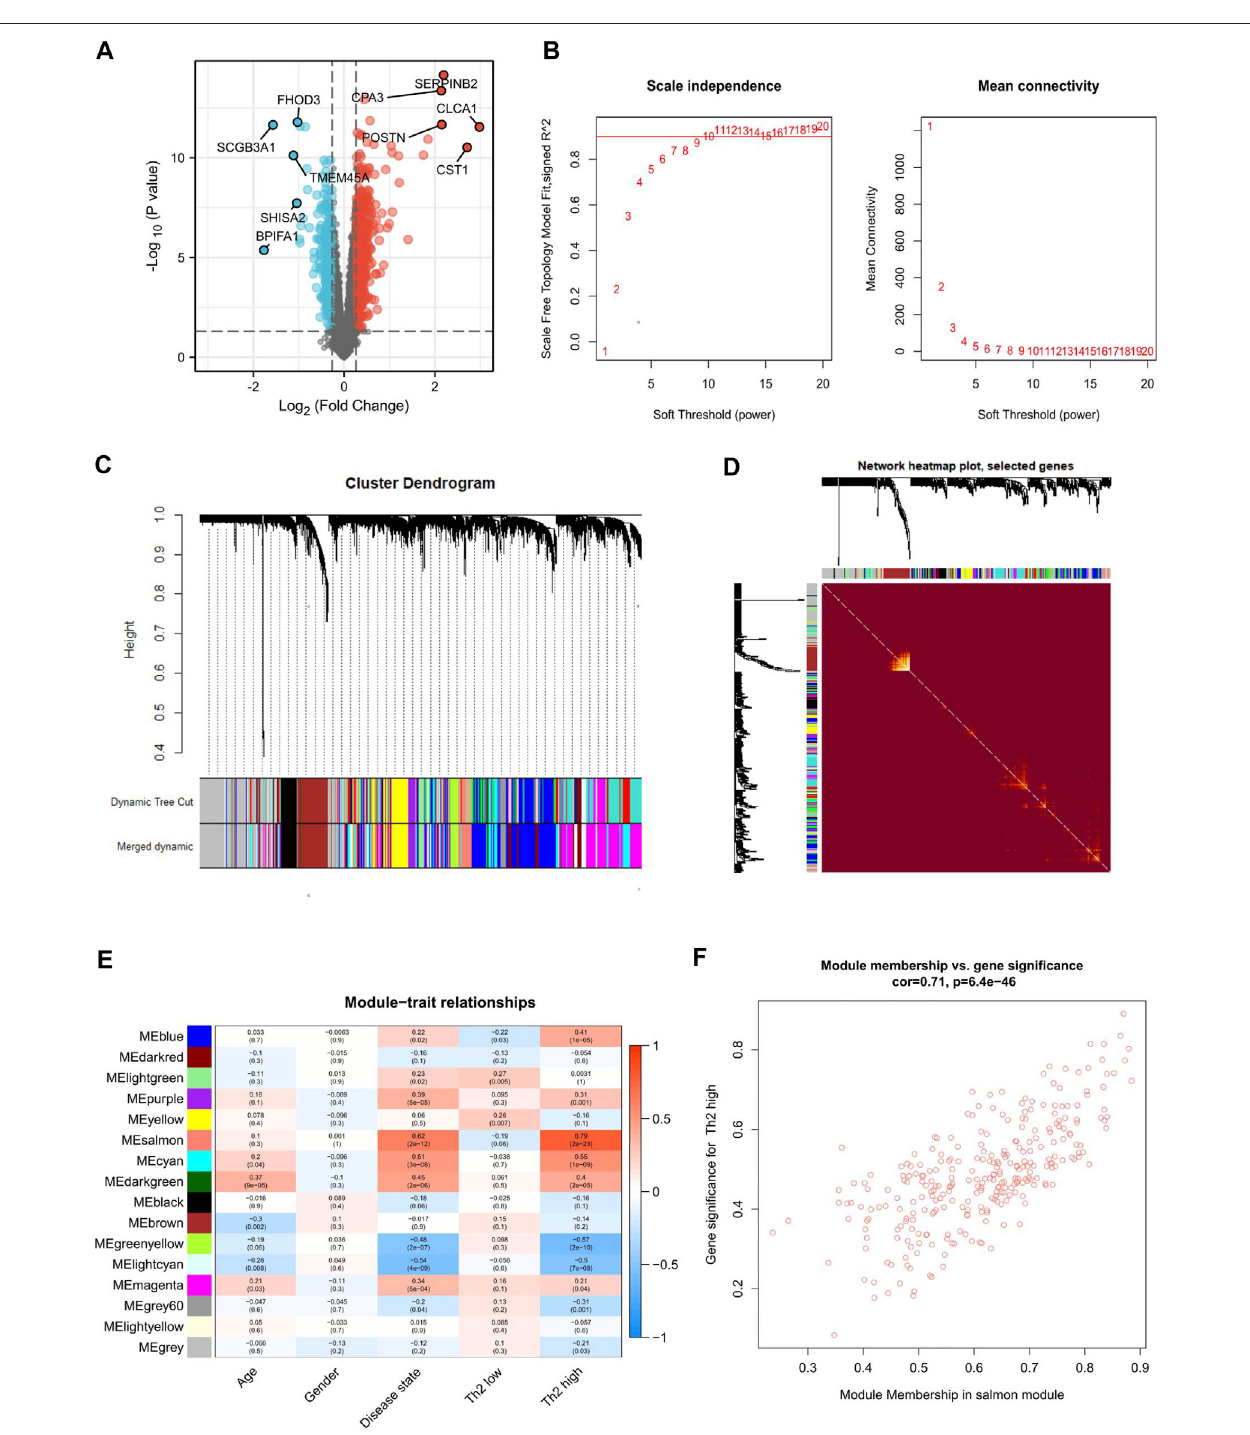
FIGURE 6 | Differential expression analysis and WGCNA identi fi cation of Th2 high asthma-associated modules. (A) Volcano plot of the differentially expressed mRNAsbetweenasthmaandhealthycontrolgroups.Theupregulatedanddownregulatedgeneswithtop fi ve ｜ logFC ｜ weremarked. (B) Theprocessofidentifyingthe most appropriate soft threshold. (C) Clustering dendrogram of mRNAs with top 40% variances in the co-expression network. (D) Heat map depicting the topological overlap matrix (TOM) among genes based on co-expression modules. (E) Relationships between mRNA modules and clinical traits. (F) Correlation between module membership of salmon module and gene signi fi cance with Th2 high asthma.